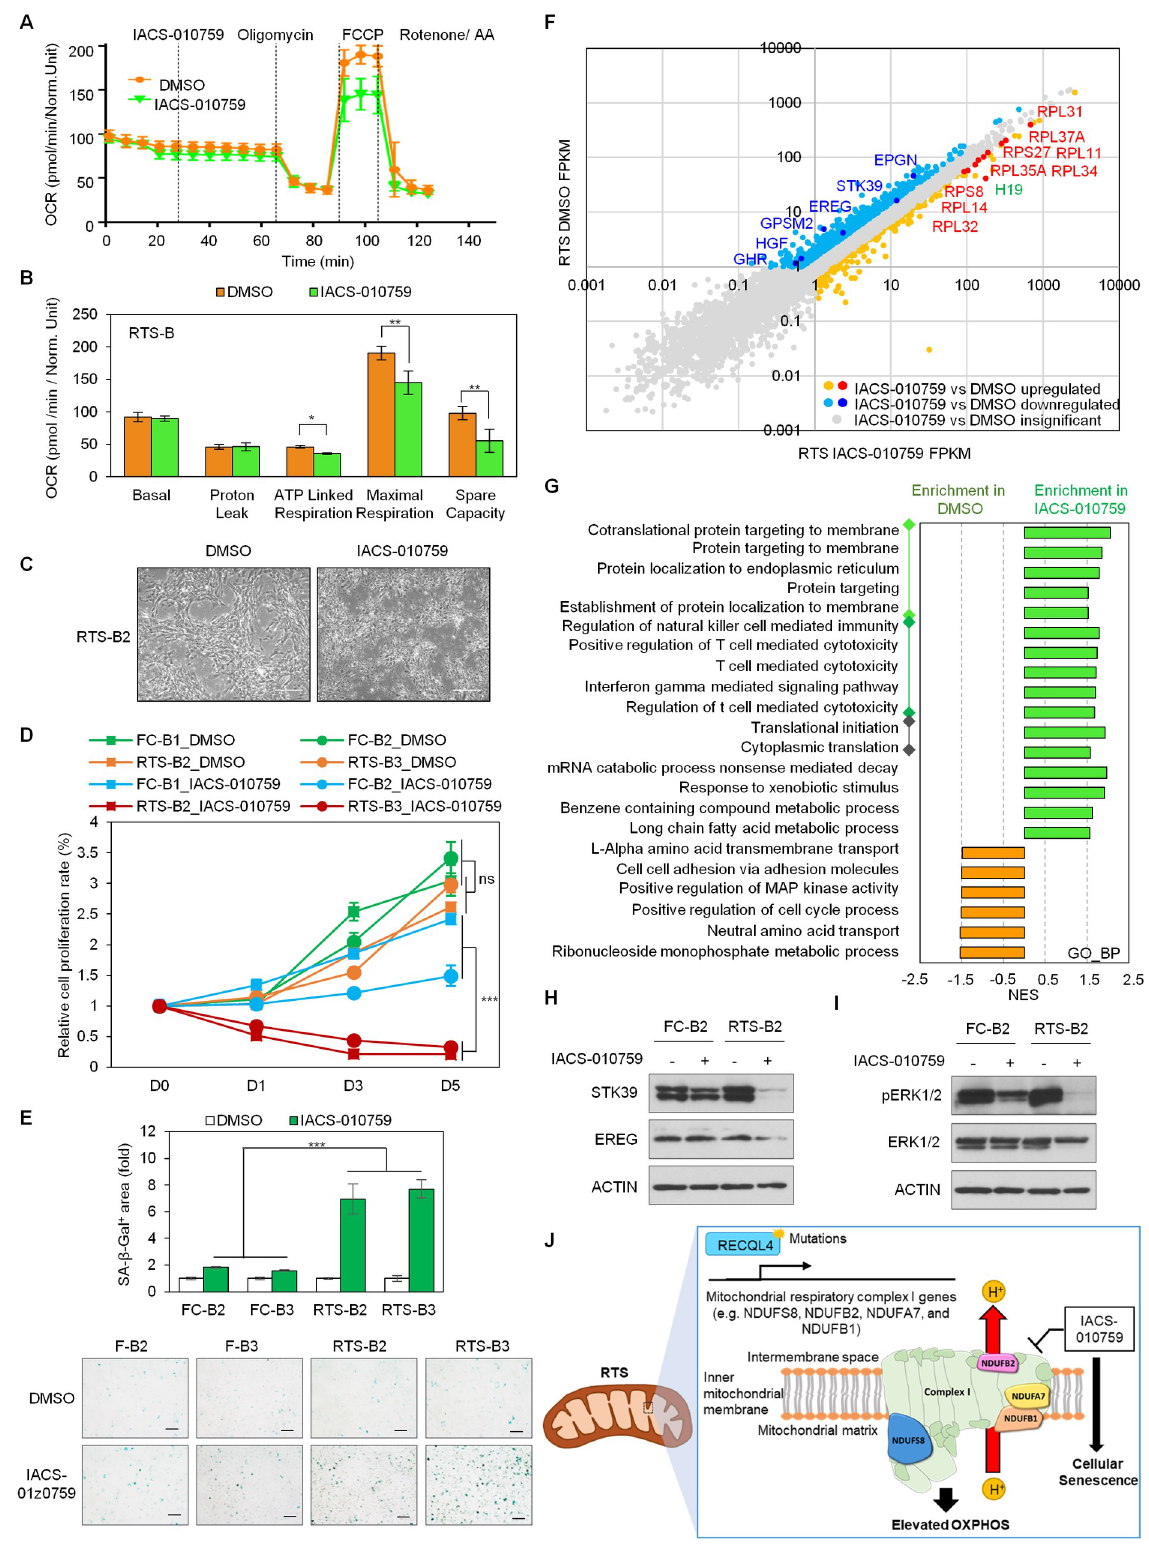
Fig 5. Inhibition of mitochondrial respiratory complex I specifically impairs ATP respiration, reliance on OXPHOS, and survival in RTS osteoblasts. (A-B) RTS osteoblasts treated by 100 nM of IACS-010759 show reduced ATP respiration, maximal respiration, and